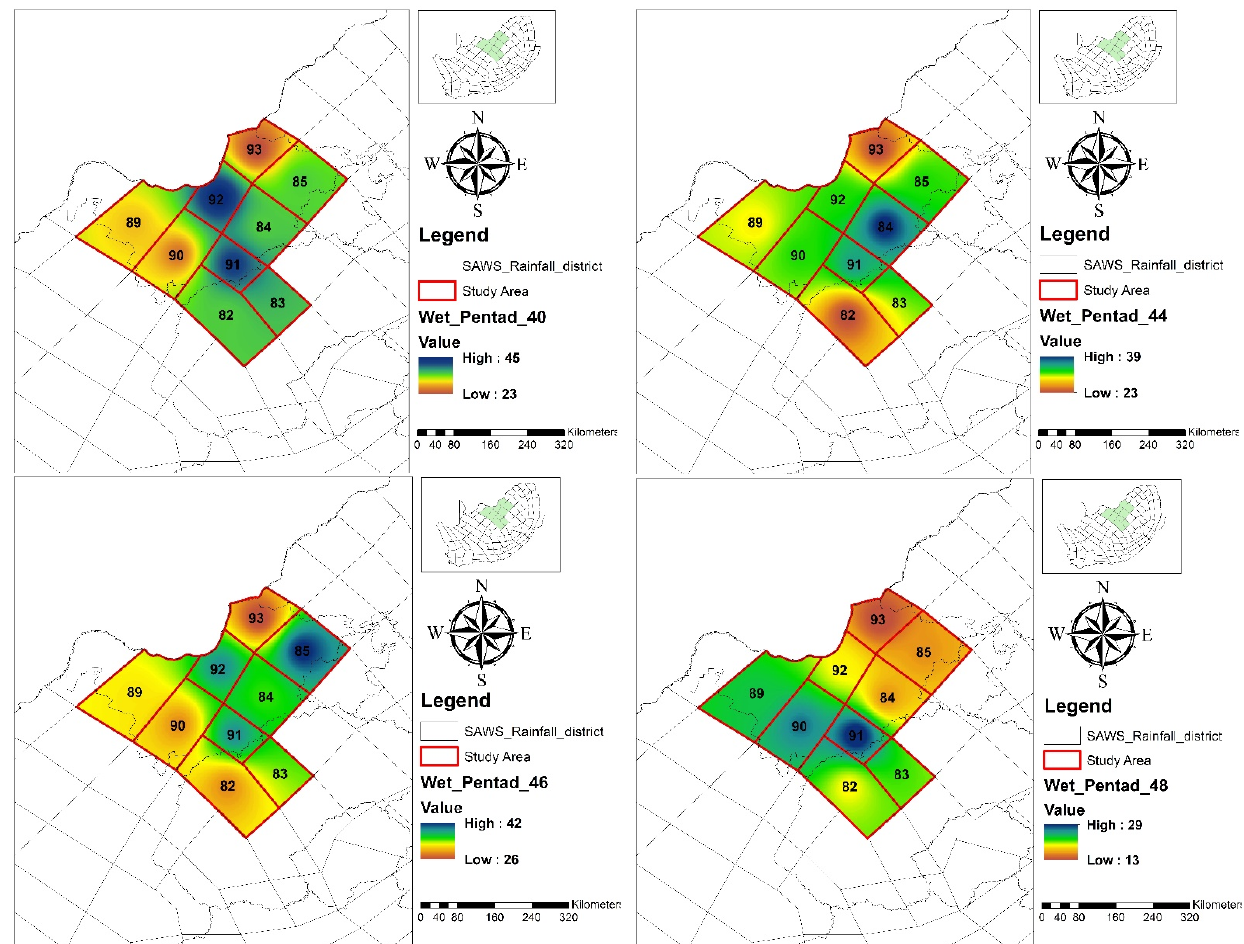
Figure 7. Spatial analysis of initial wet ‐ spell probability ( Pw ) for pentad 40, 44, 46, 48.